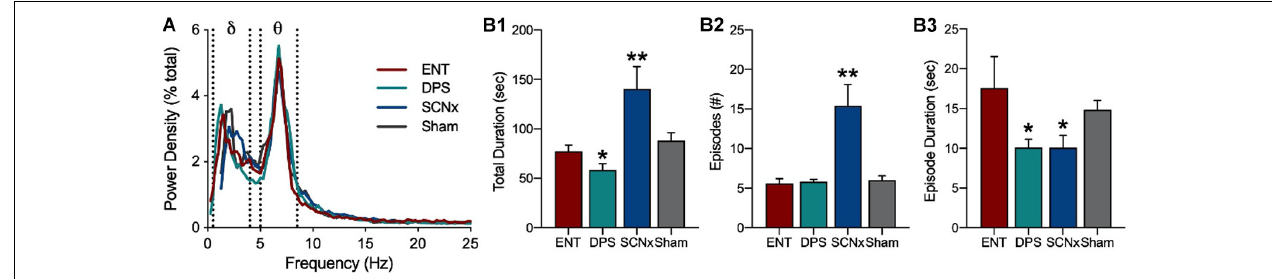
FIGURE 6 | Loss of circadian timing fragments theta oscillations. (A) Power density in the EEG averaged over 5 min of object exploration. Delta ( δ ) and theta ( θ ) power bands defined by dotted lines. Data for ENT, DPS, SCNx, and Sham groups are aligned by peaks in theta power. Theta dominance was defined by a theta/delta (T/D) ratio > 1.0 within each EEG epoch. (B) Theta dominance in the EEG during exploration of a novel object given for (B1) total amount of time T/D > 1.0, (B2) number of theta-dominated episodes, and (B3) the mean duration of individual episodes where T/D was > 1.0. Data are mean ( ± SEM). * indicates P < 0.05, ** P < 0.01 compared to ENT. Figure modified from Loewke et al.